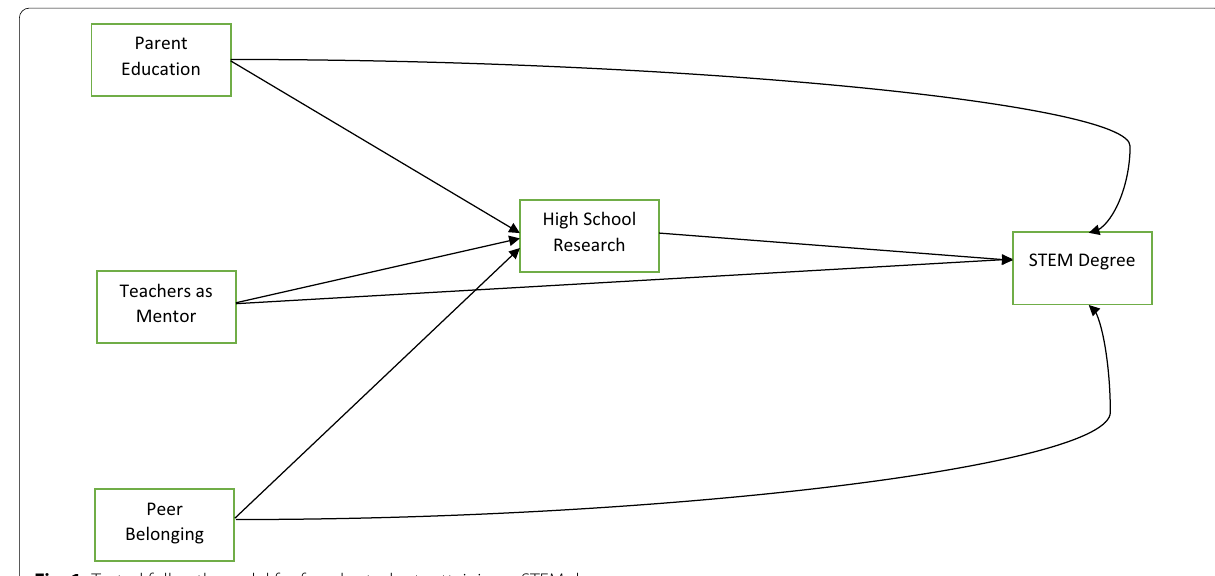
Fig. 1 Tested full path model for female students attaining a STEM